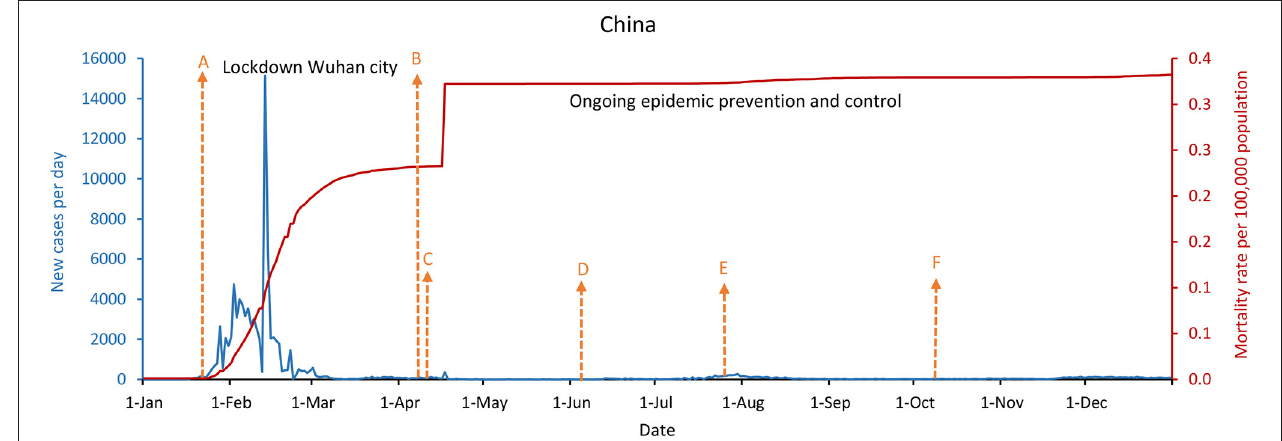
FIGURE 1 | China’s coronavirus disease 2019 (COVID-19) epidemic curves and population mortality rate (between January 1 and December 31, 2020). (A) Beginning of January 23, 2020, lockdown Wuhan city, all provinces or regions initiated a Class 1 Response Public Health Emergency. (B) Beginning of April 8, lifting lockdown of Wuhan city, and entering the phase of ongoing epidemic prevention and control. (C) On April 9, a COVID-19 cluster was detected in Heilongjiang Province. (D) On June 4, a COVID-19 cluster emerged at Xinfadi Market in Beijing. (E) On July 26, COVID-19 cases were mostly from outbreaks in Xinjiang and Liaoning. (F) On October 11, a COVID-19 cluster appeared in Qingdao.